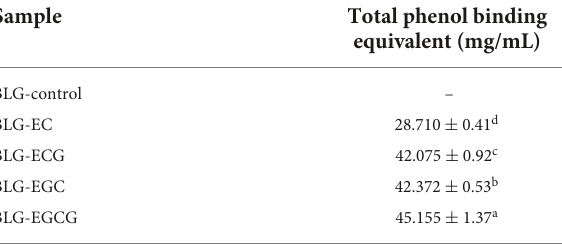
TABLE 1 Total phenolic content of BLG and BLG-catechin